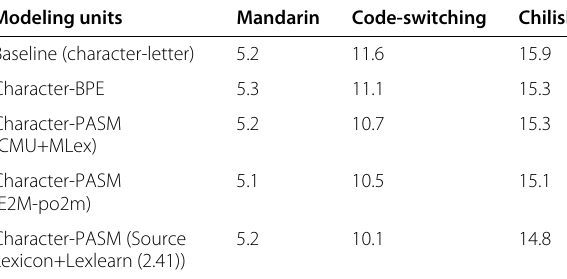
Table 5 Results (TER%) of Transformer-based E2E CS